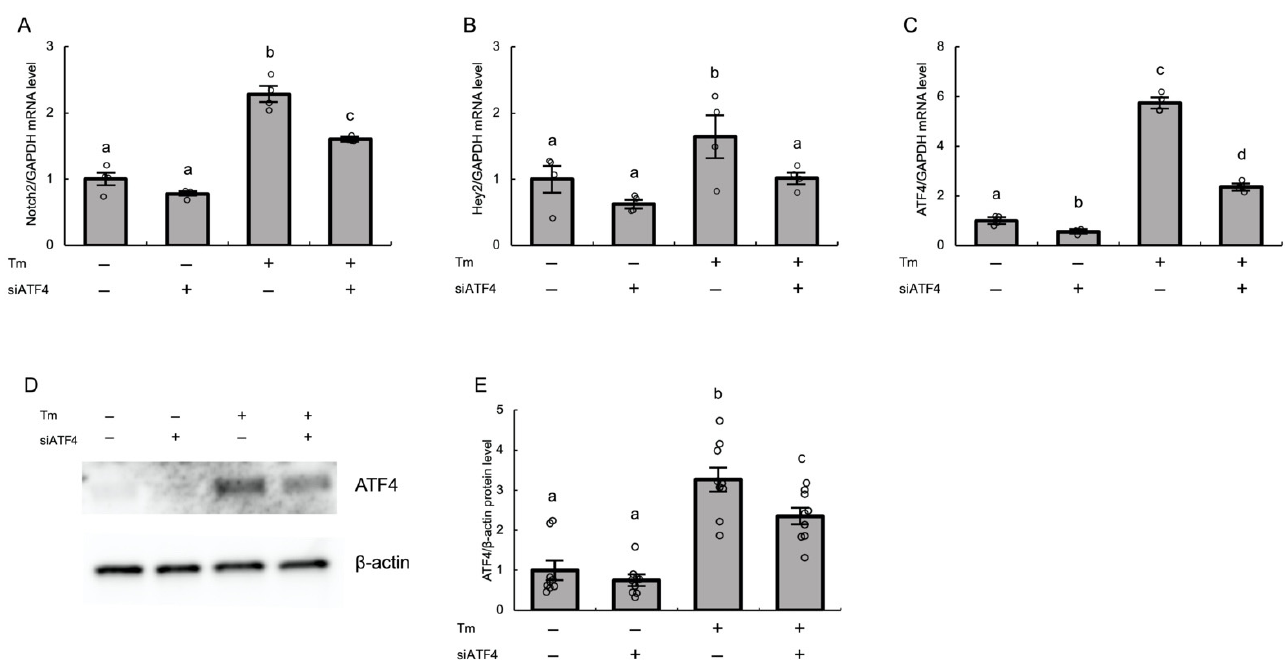
Figure 4. ER stress induces Notch2 signaling via the ATF4 pathway in cultured human GLCs. Human GLCs were transfected with siATF4 or negative control siRNA for 24 h and then treated with tunicamycin (2.5 µg/mL) for 24 h. The expression levels of ( A ) Notch2, ( B ) Hey2, and ( C ) ATF4 mRNAs were measured by real-time PCR and normalized to that of GAPDH. ( D ) The protein expression level of ATF4 in GLCs was analyzed by western blotting. β -Actin was used as a loading control. ( E ) Quantitative analysis of western blotting. Values represent means ± SEM, relative to the mean control value. The letters denote significant differences between groups. Tm, tunicamycin.